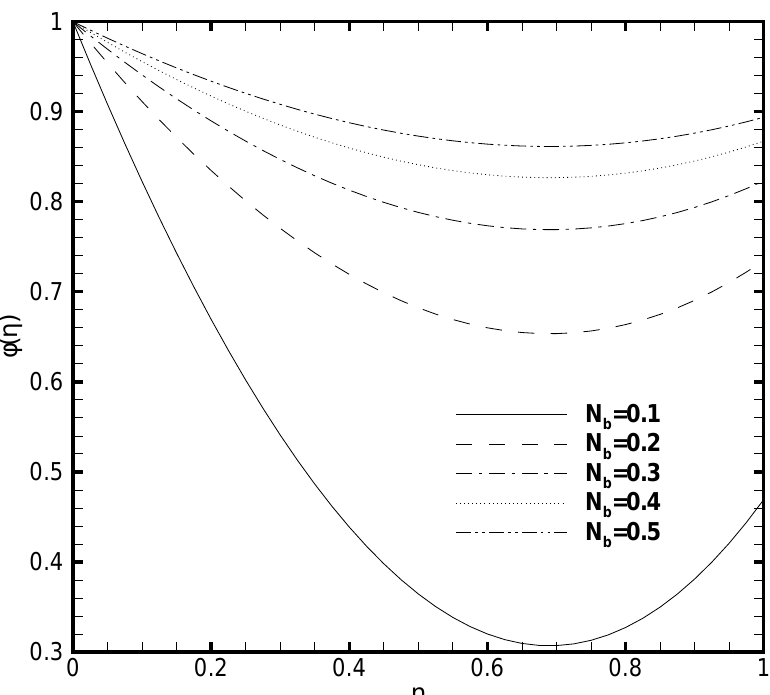
Figure 11. Nanoparticle volume fraction profile φ ( η ) for several values of Brownian motion parame- ter N b when ζ = P = κ = Ha = Br = δ θ 2 = F k = 1, N t = 0.1, β = 0.05 and δ θ 1 = 0.5.